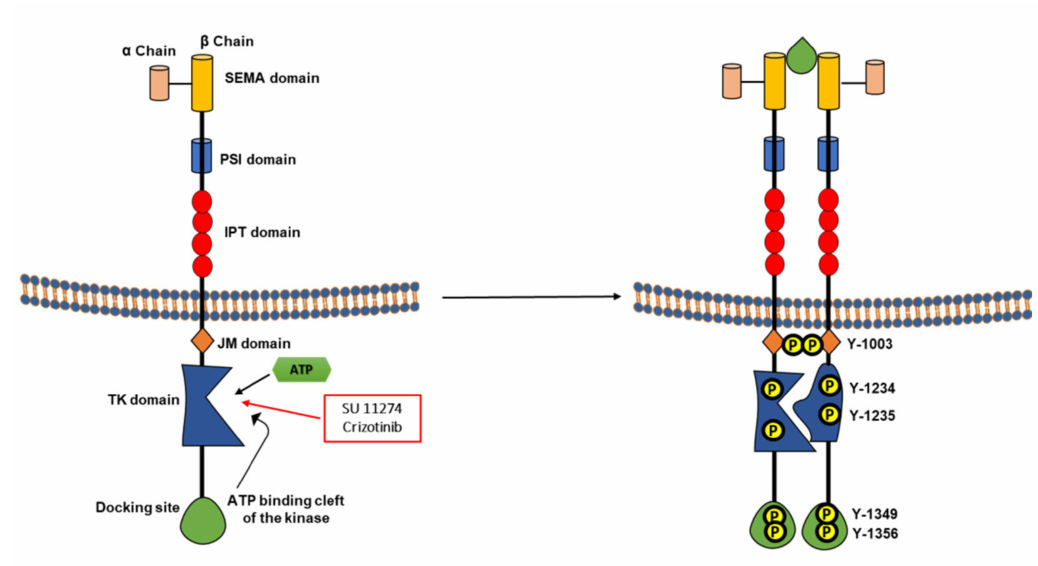
Figure 3. HGFR structure and activation. ( A ) ECD domain of HGFR consists of disulfide bond-linked α and β subunits, which consist of Sema, PSI, and IPT domains, followed by a transmembrane domain (TM), juxtamembrane domain (JM), tyrosine Kinase domain (TK), and docking sites for adaptor proteins. ( B ) HGF/SF in absence or presence of accessory molecule such heparin bind ECD (dimerization) that mediates autophosphorylation of specific tyrosine residues (Y1003, Y-1234, Y1235, Y1349, Y1356). HGFR-tyrosine kinase inhibitors bind the ATP-binding pocket of the kinase